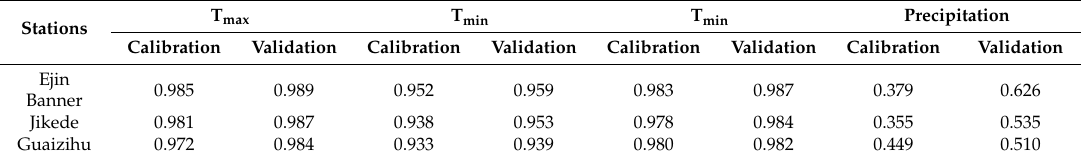
Table 4. Deterministic coefficients of the statistical downscaling model (SDSM) during calibration and validation